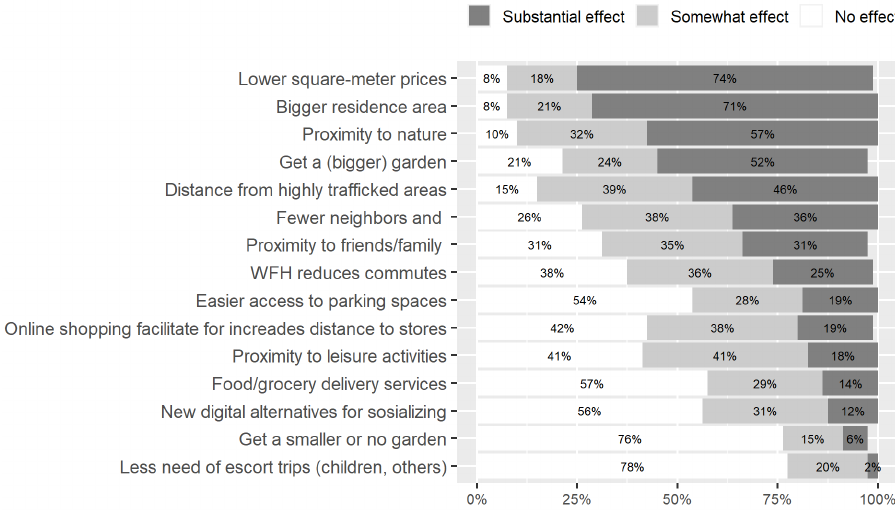
Figure 2. The assessed effect of each aspect on preferences for decentralization (n =